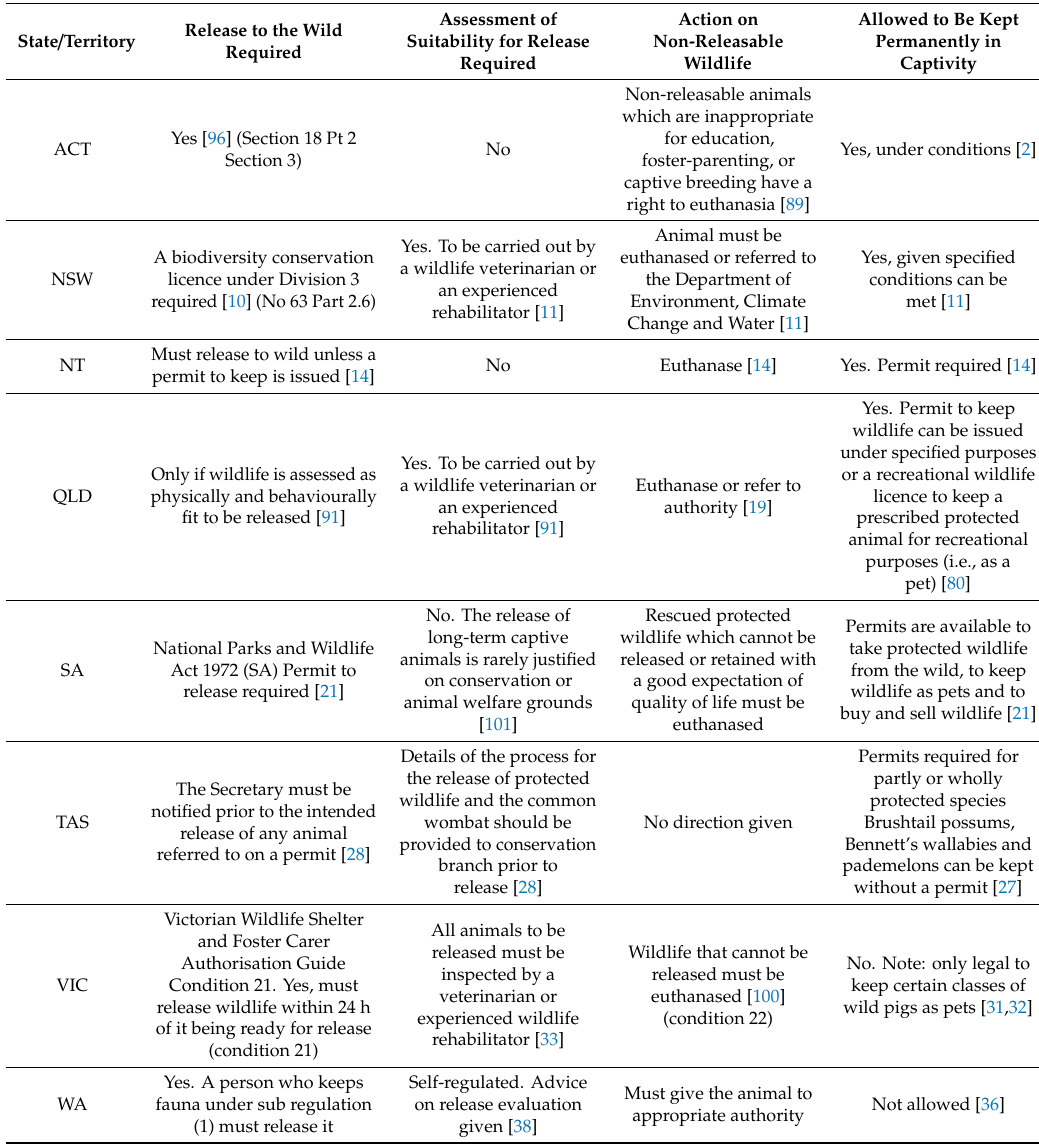
Table 7. Published Australian protocols for releasing or not releasing rehabilitated native fauna to the